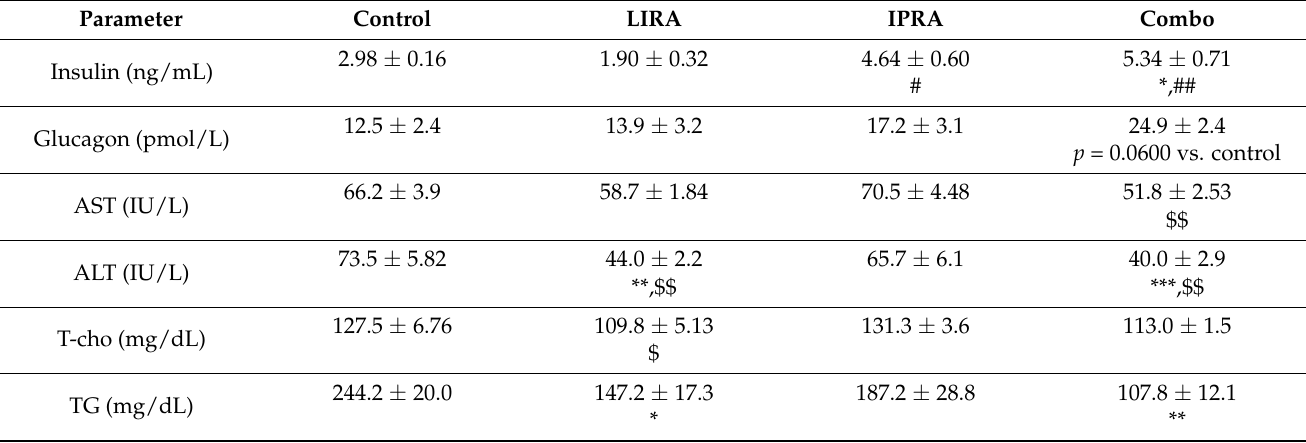
Table 2. Plasma biochemical parameters in db/db mice after drug